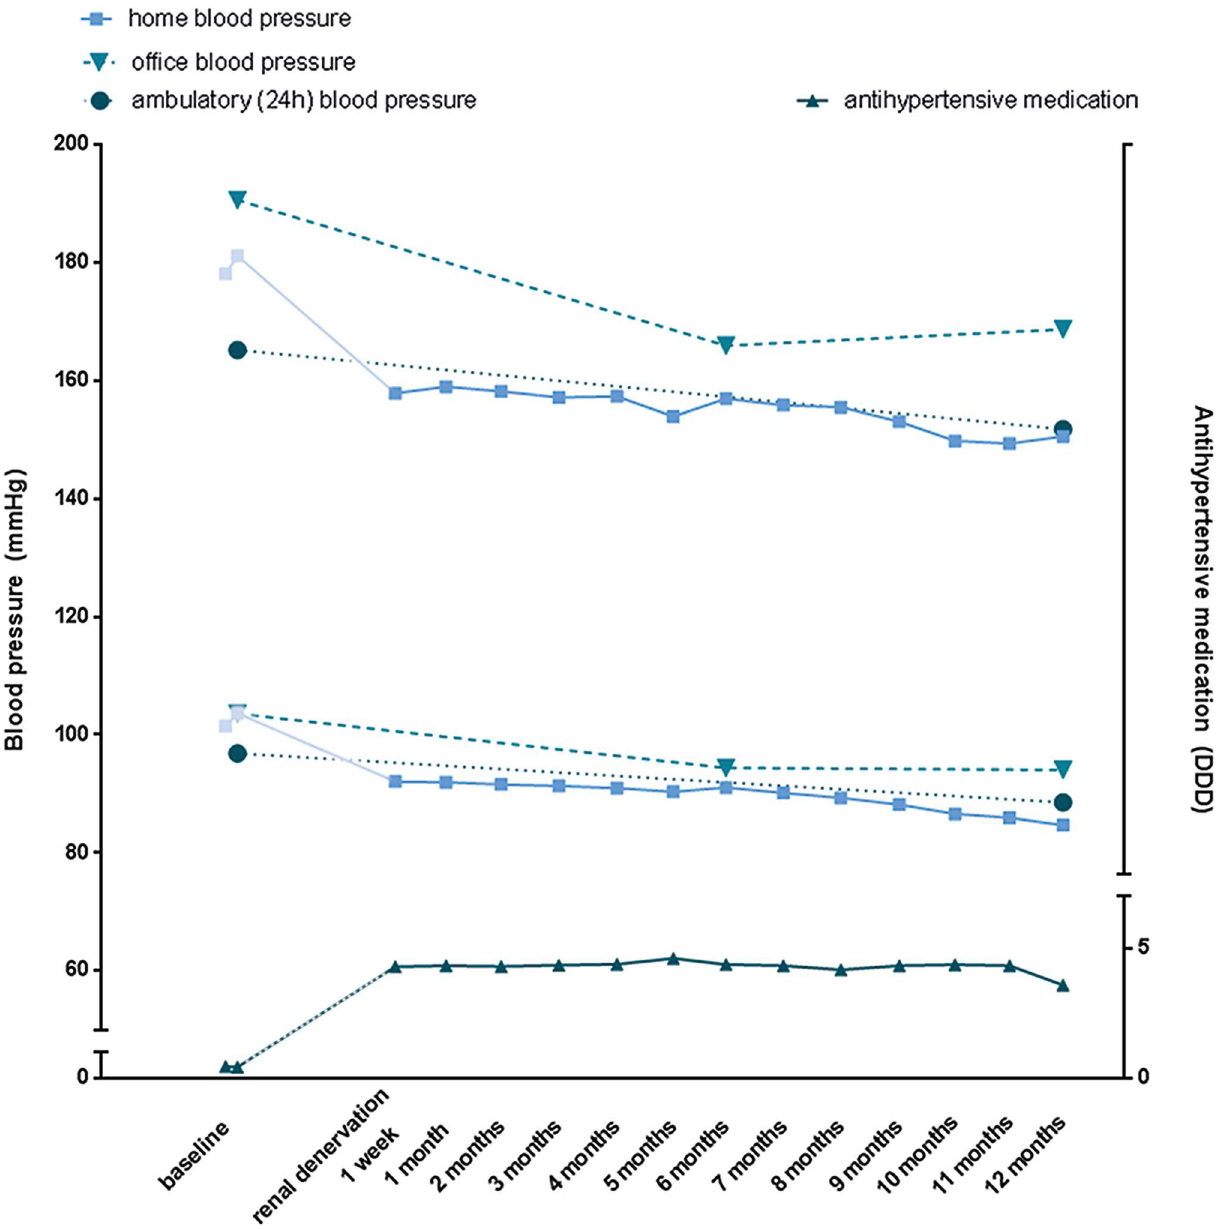
Fig 2. Changesin bloodpressuremeasuredby various modalities and antihypertensivemedicationover time. Figuredepicts the change in blood pressuremeasuredby various modalities(displayed on left axis) and antihypertensive medication (displayed on rightaxis). SD bars for BP overlapped for both baseline and 12-monthfollow-up, indicatinglack of statisticalsignificance, but were omittedin the figure for